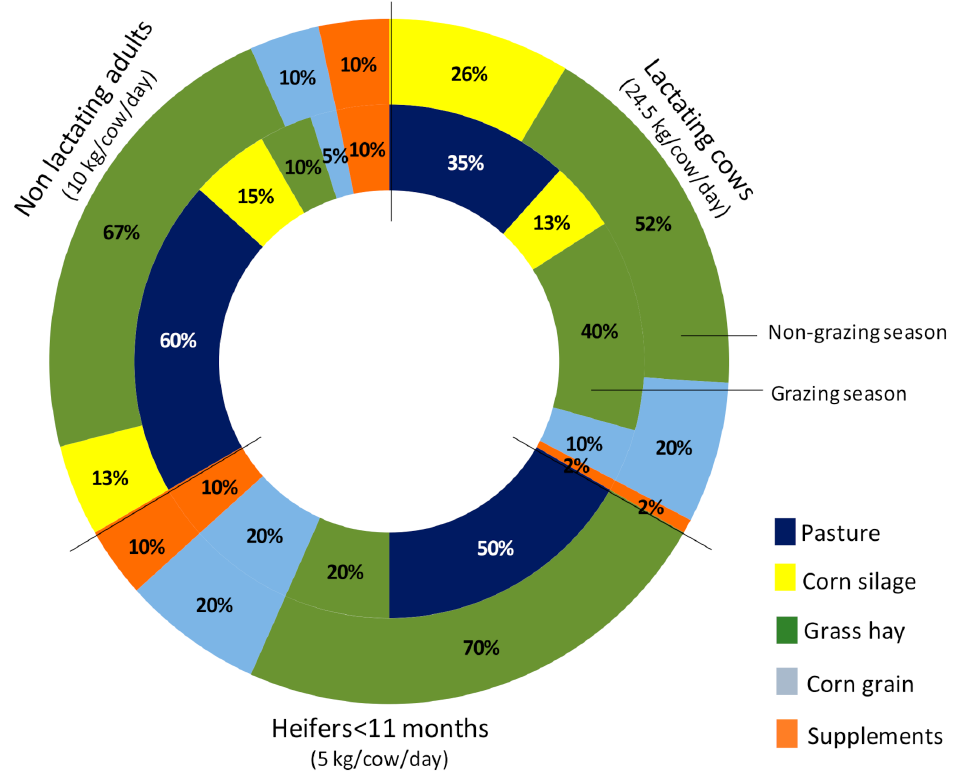
Figure 2. Diet composition of the small farm (150 Holstein lactating cows) for lactating and nonlactat- ing cows during the grazing and non-grazing